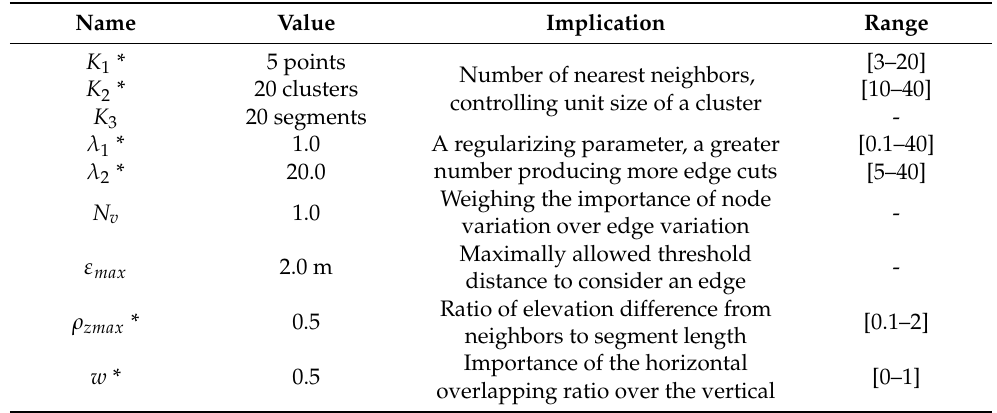
Table 2. Parameters and default values of treeiso . The K and λ represent different stages of segmenta- tion. The parameter range is the sampling space for sensitivity